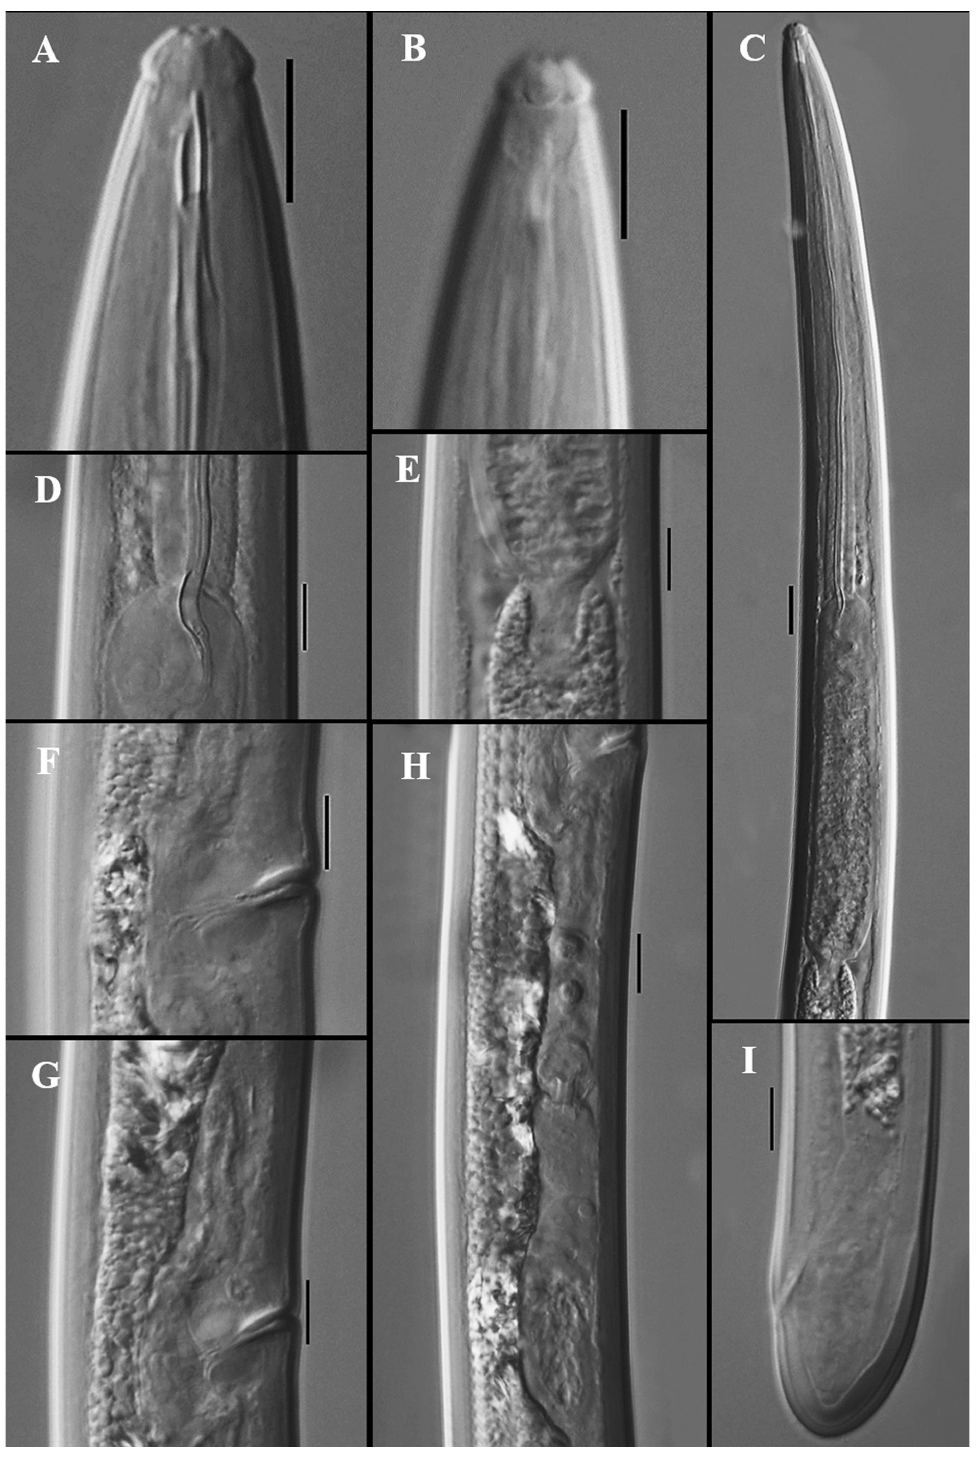
Fig. 6. Axonchium indicum sp. nov. (LM photographs). A – B . Paratype 2, ♀ (slide 2). C – I . Paratype 6, ♀ (slide 4). A . Anterior region. B . Anterior end showing amphid. C . Pharynx. D . Junction between two parts of the pharynx. E . Cardia. F . Vulva. G . Anterior uterine sac. H . Posterior genital branch. I . Posterior region. Scale bars: A–B, D–I = 10 µm; C = 20